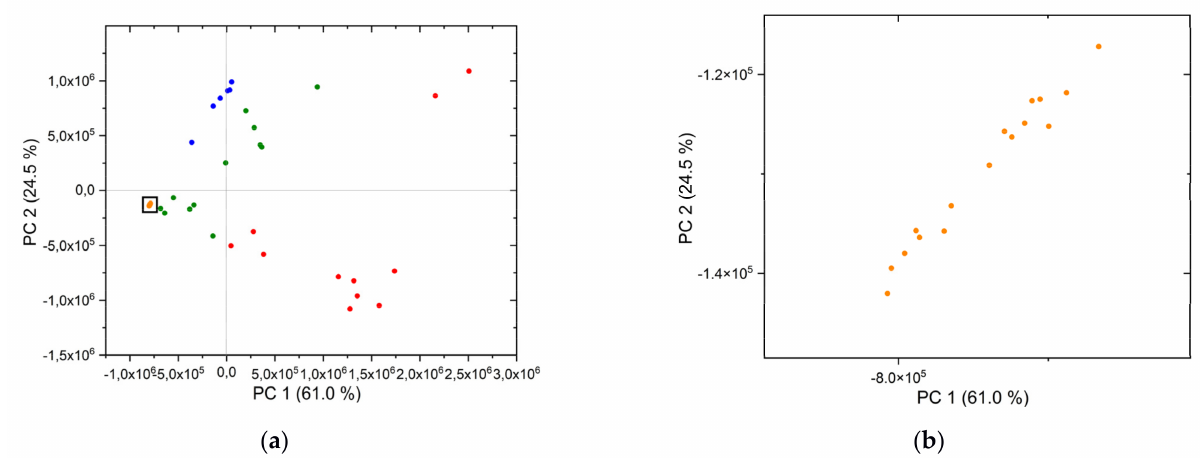
Figure 8. ( a ) PCA of reference rock and synthetic samples (Ce), ( b ) magnification of area with synthetic samples (Ce): blue Fen complex, green Olserum, red Norra Kärr, orange synthetic samples (Ce).